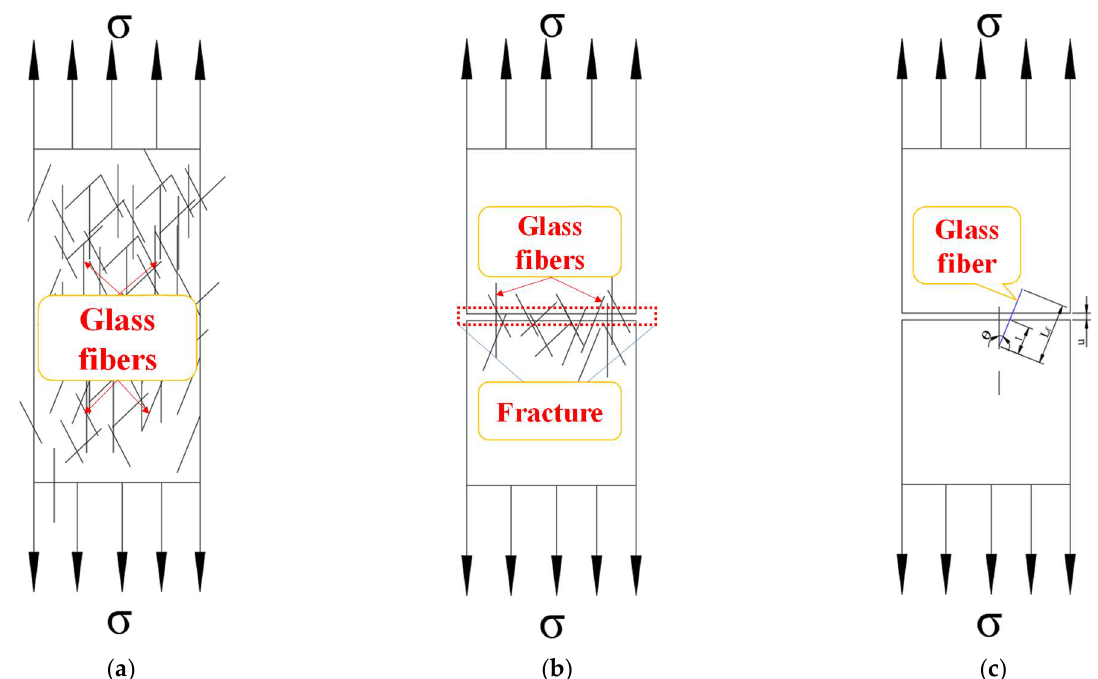
Figure 17. Mechanical model of fibers’ effect on the strength of specimens. ( a ) Before fractur. ( b ) After fracturing. ( c ) A single fiber.